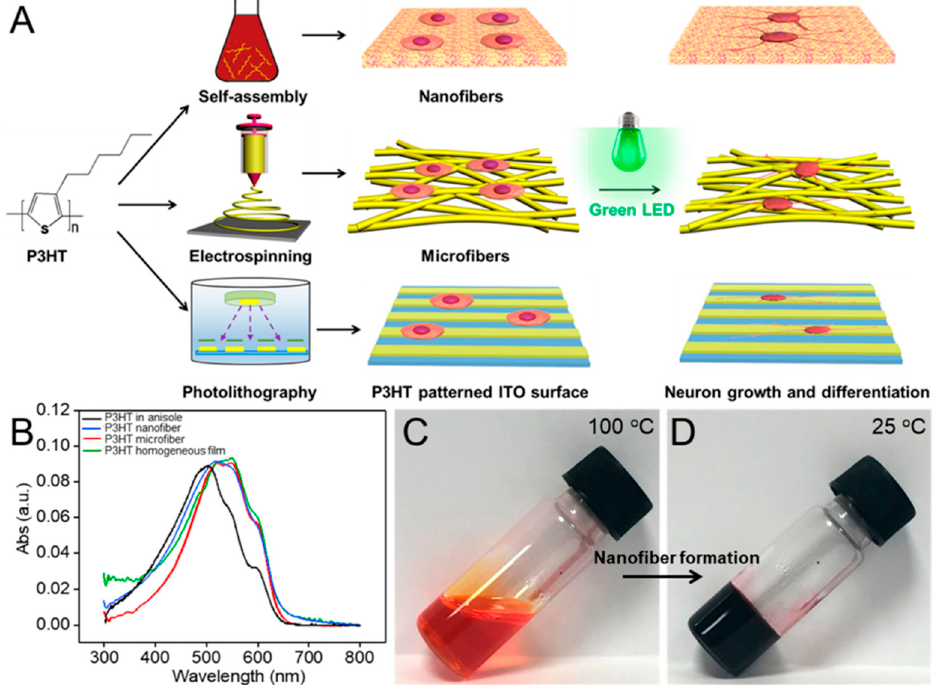
Figure 9. ( A ) Schematic illustration of the preparation of P3HT micro/nanofibers and P3HT-patterned surface for PC12 cell culture. ( B ) UV-vis absorption spectra of P3HT polymer in anisole solution, P3HT micro/nanofiber, and homogeneous films. ( C , D ) Digital photographs of P3HT in hot anisole (100 °C) ( C ) and after being cooled to 25 °C ( D ). Reprinted with permission from ref [93]. Copyright 2022 American Chemical Society.